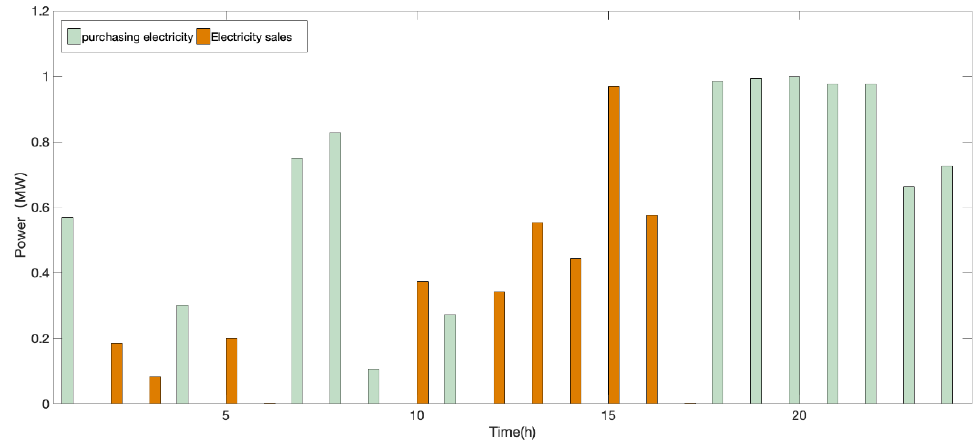
Figure 7. Robust strategy for DERAs in the day-ahead market.